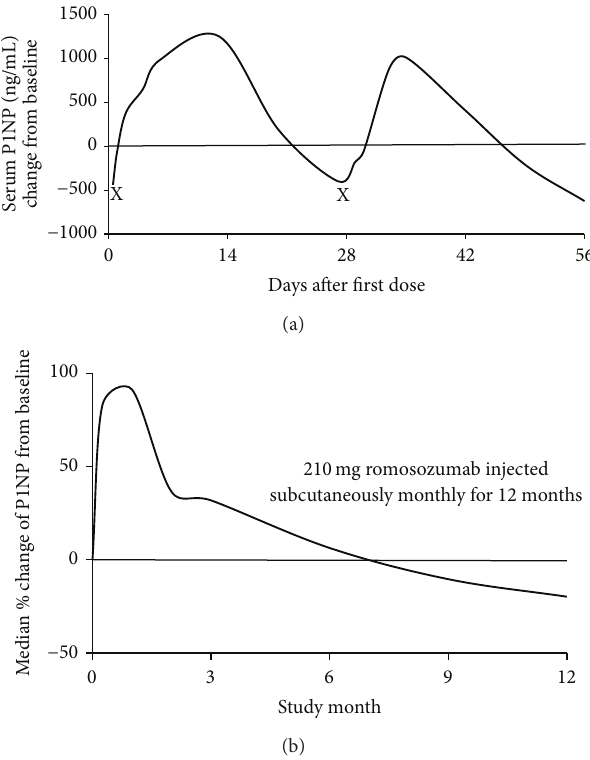
Figure 3: Change in serum concentrations of P1NP after mul- tiple doses of anti-sclerostin antibodies in cynomolgus monkeys (a) and humans (b). (a) After 30 mg/kg, subcutaneous dose of romosozumab P1NP levels (a marker of bone formation) increases in cynomolgus monkeys. Subsequently, P1NP levels decline before increasing subsequent to the second dose of romosozumab on day 29 (day of administration delineated by “X”). (b) This sharply con- trasts with median levels of P1NP observed in human subjects after monthly doses of 210mg (total monthly dose) of blosozumab over a 12-month period. Here a sharp increase in P1NP is observed after initial administration which peaks after the second subcutaneous injection of romosozumab at 1 month. Despite subsequent monthly doses, P1NP levels continue to decline and were observed to fall below baseline levels after 7 months, where levels remained until 12 months(demarcatedtheendofthestudy)[imagesadaptedfrom[52] (a) and [55]